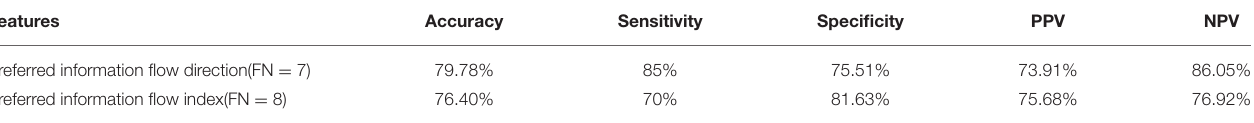
TABLE 2 | Identification of EMCI by using information flow measures by SVC.